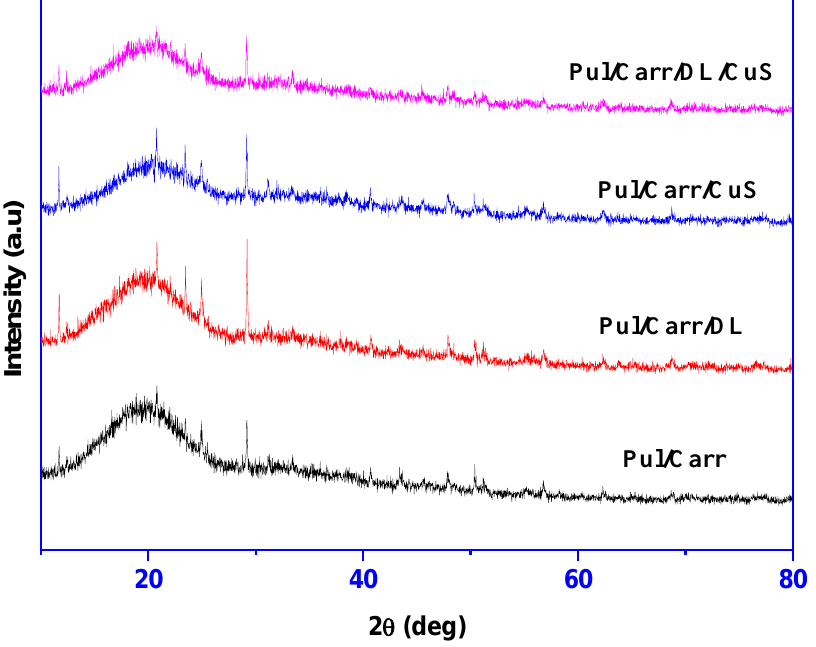
Figure 4. XRD pattern of pullulan / carrageenan-based